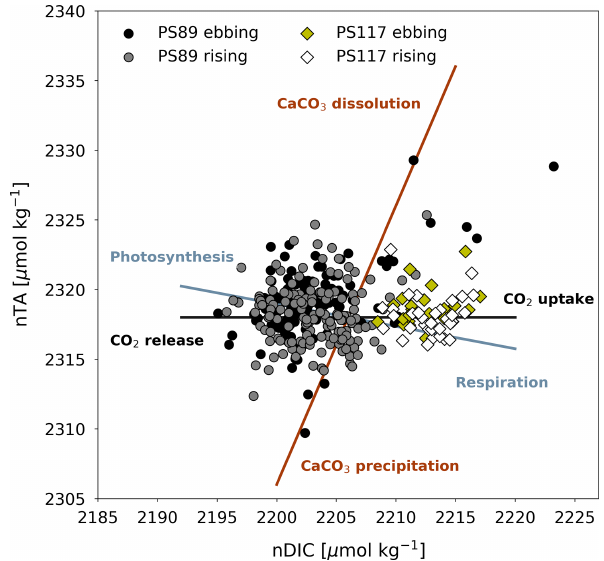
Figure 5. Salinity-normalised TA (nTA) and DIC (nDIC) plotted against each other for PS89 (circles) and PS117 (diamonds) tidal data. Samples collected during ebbing (black circles and yellow di- amonds) or rising tide (grey circles and white diamonds) are differ- entiated by different marker colours. Theoretical process lines are drawn for CaCO 3 dissolution and precipitation, photosynthesis and respiration, and CO 2 uptake and release (Zeebe and Wolf-Gladrow,